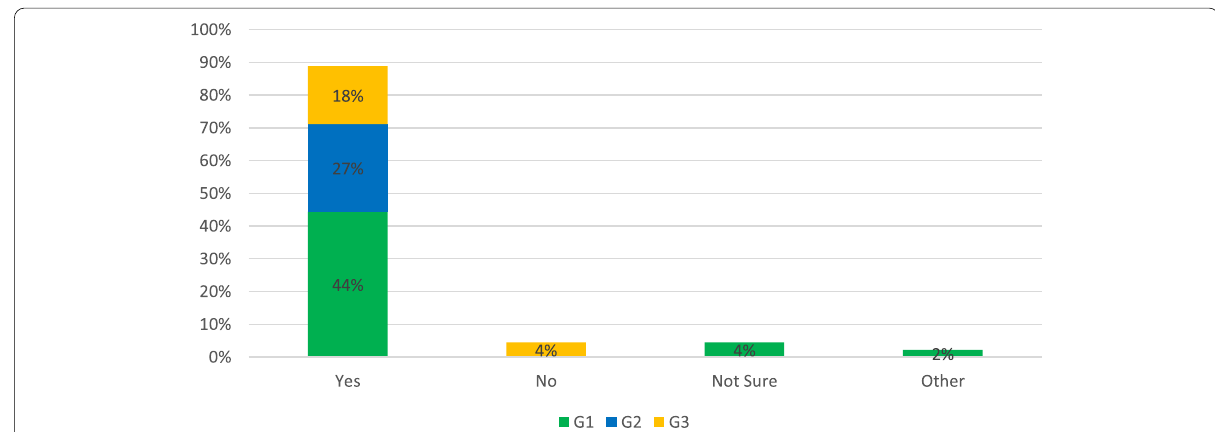
Fig. 5 Response to: Do you think COVID‑19 provides an opportunity to reset NI’s transport emissions though better WFH